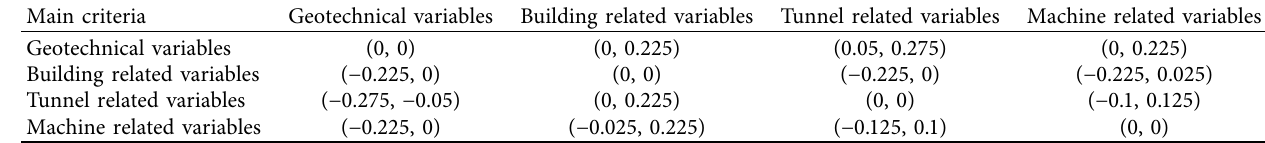
Table 5: Te diference matrix of the main criteria.